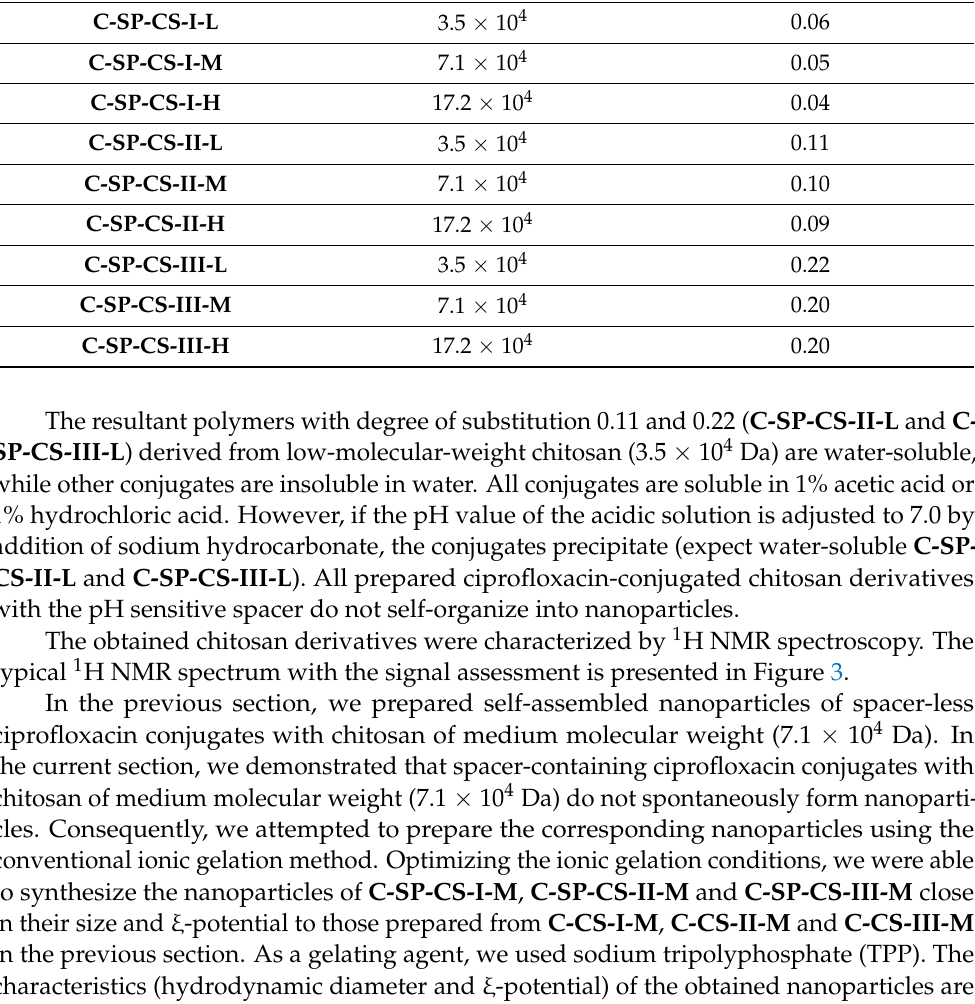
Table 5. Degrees of substitution of the obtained of ciprofloxacin-conjugated chitosan derivatives with the pH sensitive spacer (Scheme 1, system 5) and molecular weights of the starting chitosans. Ciprofloxacin/Chitosan The Molecular Weight of the The Degree of Substitution Conjugate Starting Chitosan of the Derivative